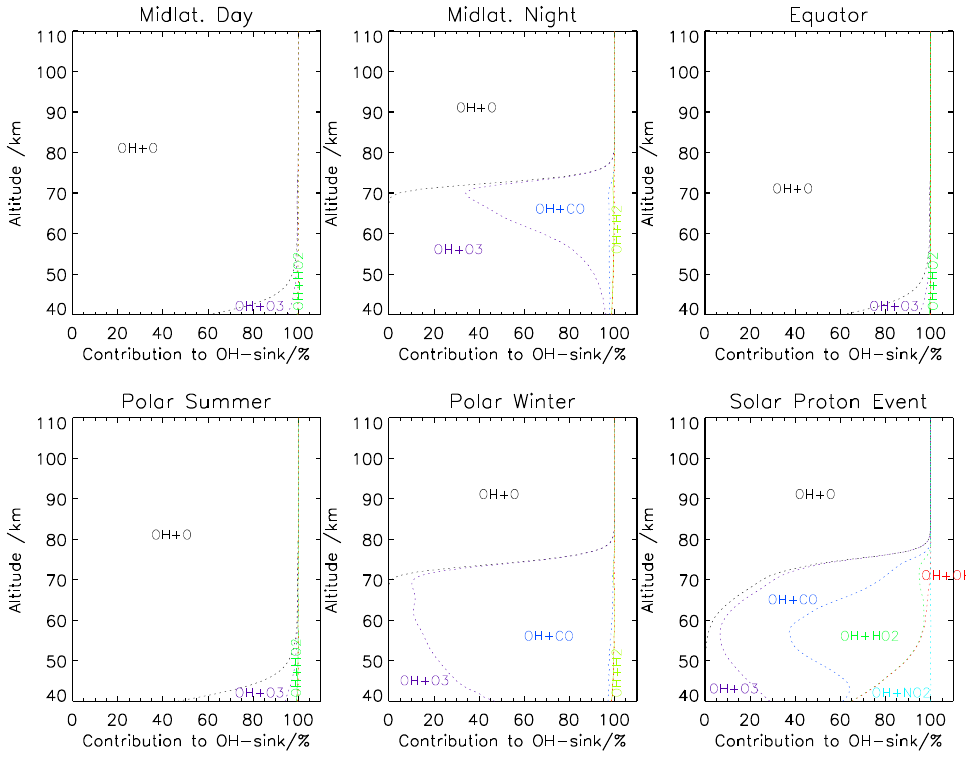
Fig. 7. Cumulative relative contribution to the OH sink of the leading reactions for various atmospheres. The areas between the lines represent the contribution of a particular reaction.